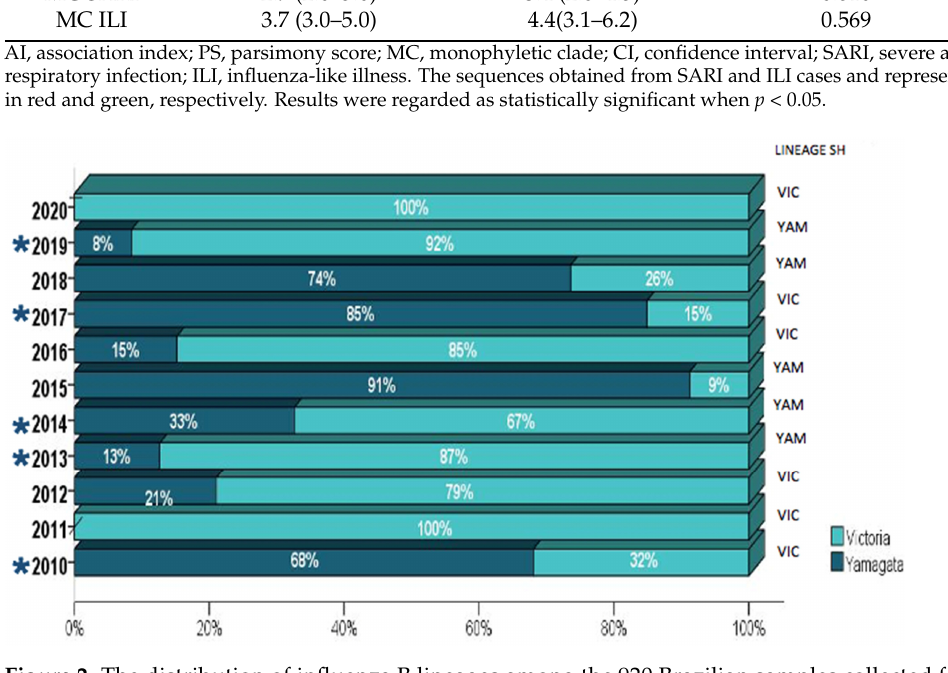
Figure 2. The distribution of influenza B lineages among the 920 Brazilian samples collected from 2010–2020. The number of tested samples for each year is further detailed in Table S2. The years where mismatches between the vaccine and circulating viruses were observed are indicated by (*). Table 3. WHO recommended influenza vaccine composition in the respective influenza seasons.